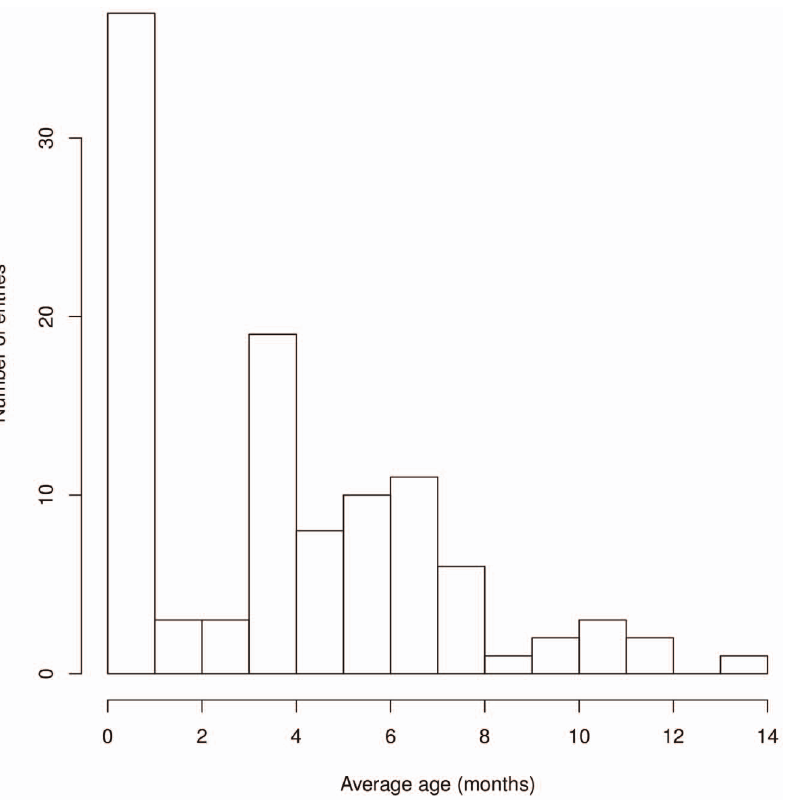
Figure 1. Age groups studied. The upper boundary of the histogram has been fixed to exclude the outlier at 27 months.